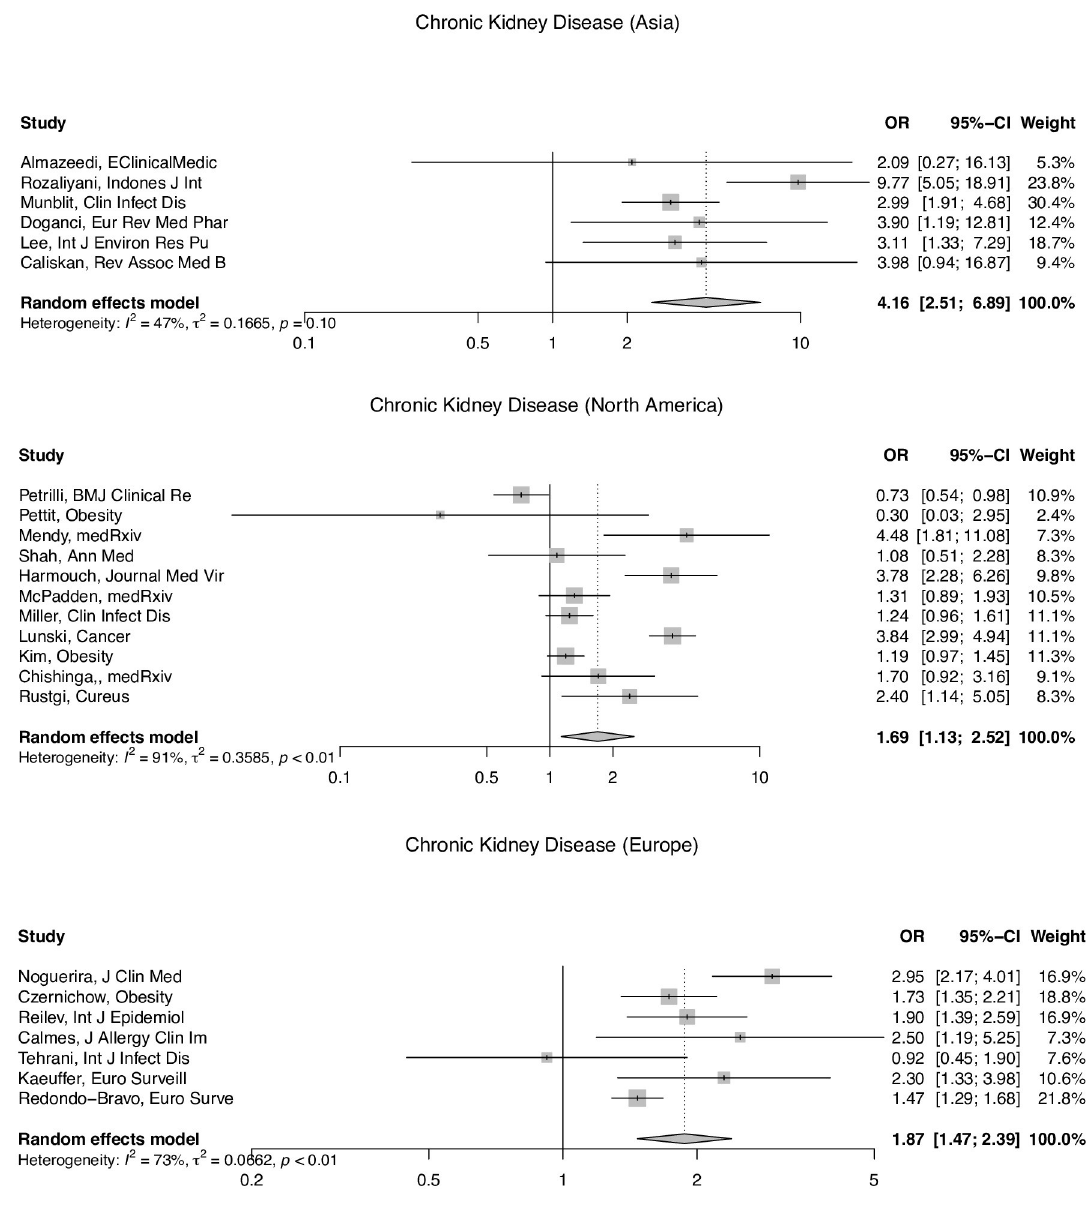
Fig 4. Stratified mortality meta-analysis for chronic kidney disease by study